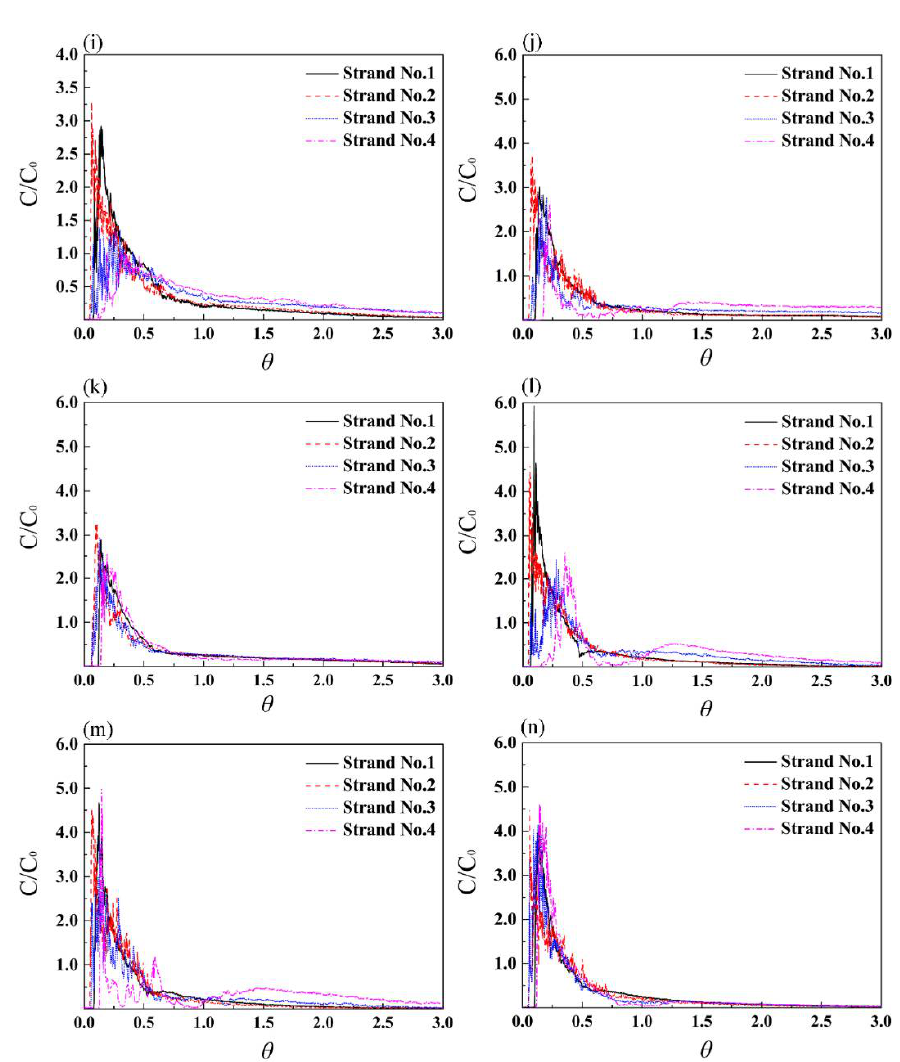
Figure 8. RTD curves of isothermal experiment Part B: ( a – n ) correspond to cases B1–B14.